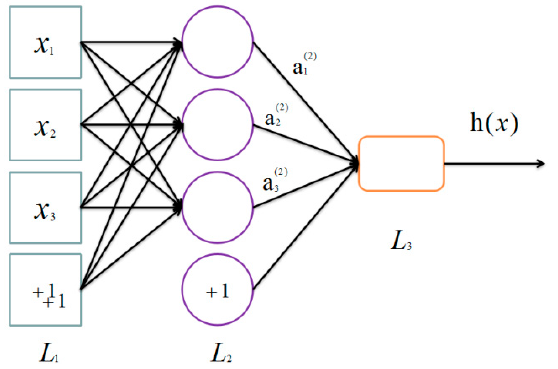
Figure 4. Basic neural network.